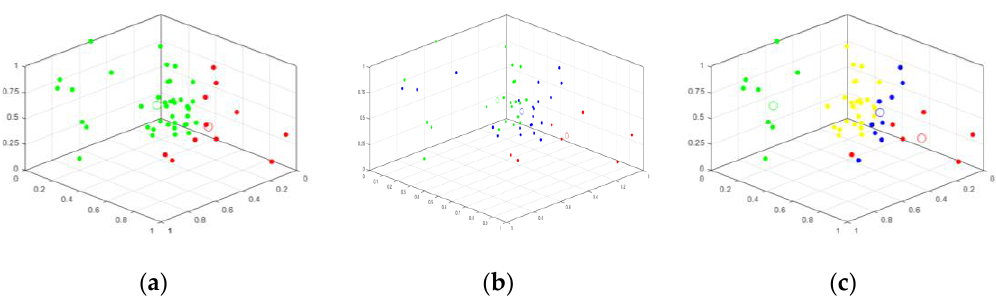
Figure 10. Clustering results of different number of clusters: ( a ) Number of clusters C = 2; ( b ) Number of clusters C = 3; ( c ) Number of clusters C = 4.